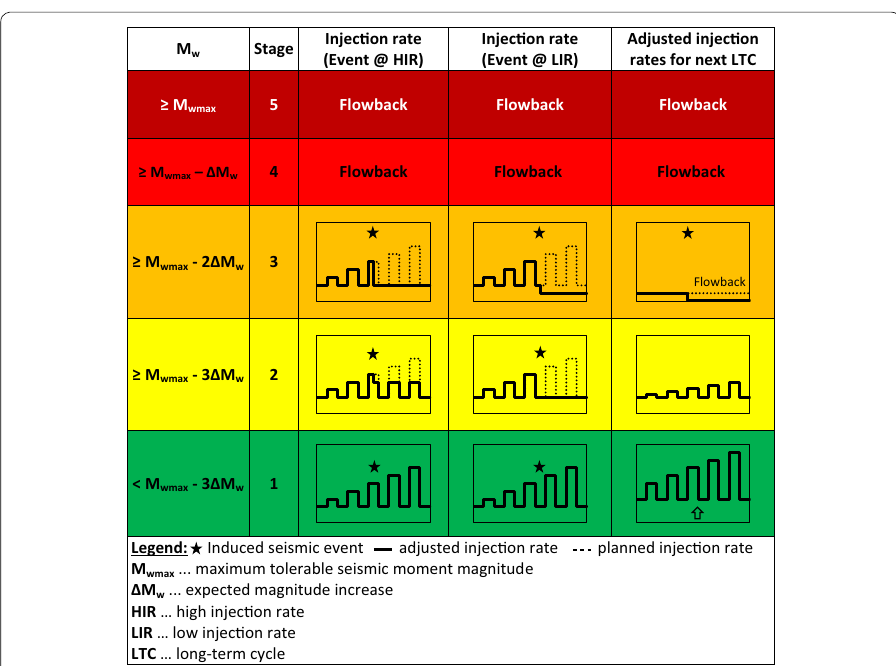
Fig. 7 Proposed traffic light system for cyclic fluid injection